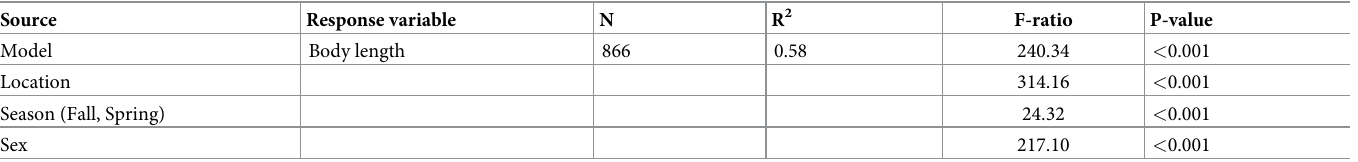
Table 1. The results from test of body length differences between sampling locations.